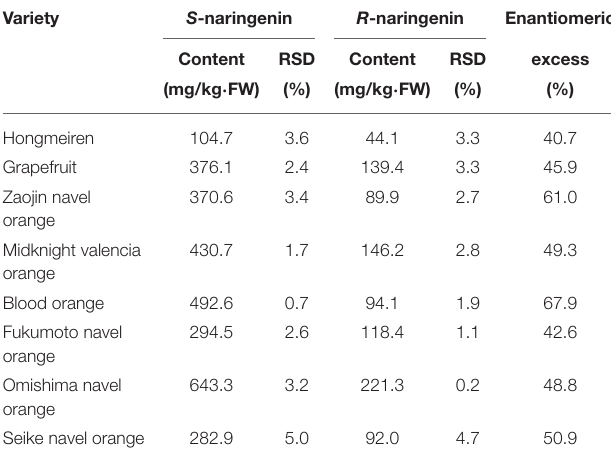
TABLE 4 | Application in determination of naringin enantiomers in different citrus peel